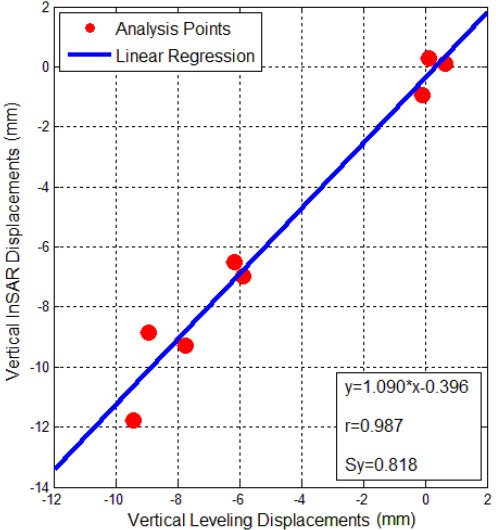
Figure 12. OLS Regression analysis in vertical displacements of the China Theater between extracted from InSAR and surveyed from leveling.